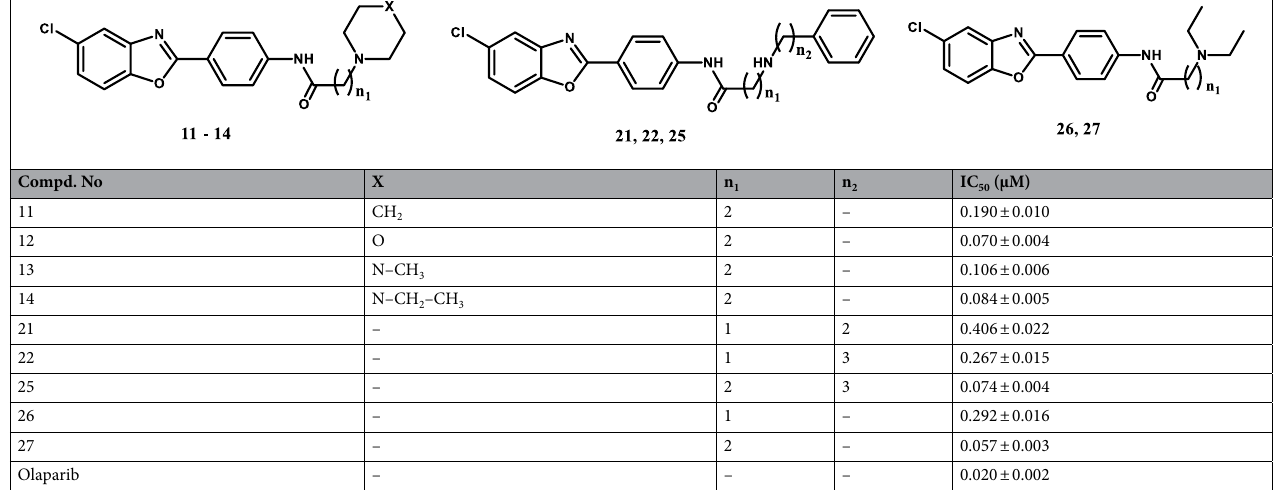
Table 2. Poly (ADP-ribose) polymerase 2 (PARP-2) inhibition results (IC 50 µM) of compounds 11–14 , 21, 22 and 25–27 against